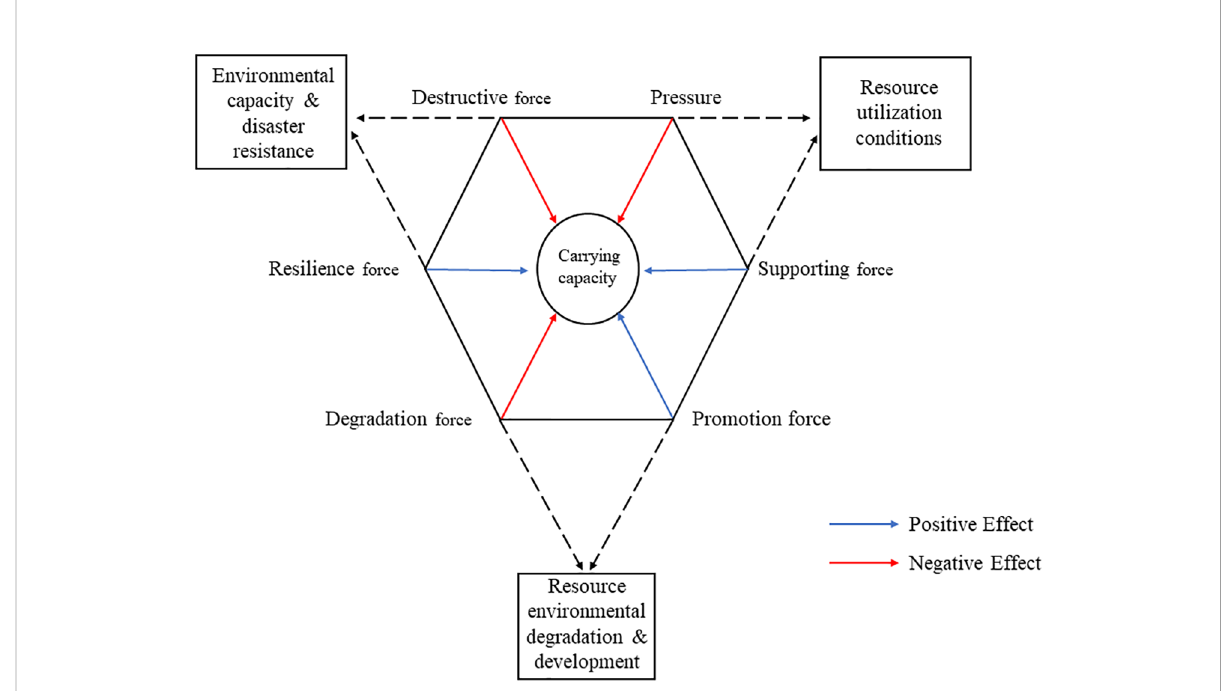
FIGURE 1 The Pressure-Support and Destructiveness-Resilience and Degradation-Promotion theoretical model of marine resource and environmental carrying